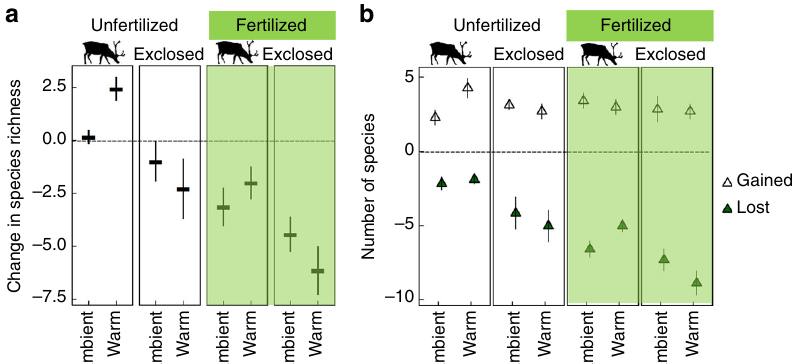
Fig. 1 Change in plant species richness from 2009 to 2014. a Changes in total plant species richness and b numbers of plant species (mean ± s.e.m., n = 7 for each point) lost and gained under warming, herbivore exclosure and fertilization treatments. Total plant species richness at the start of the experiment was 21.6 ± 0.58 (mean ± s.e.m.) species in 25 × 50 cm 2 quadrats ( n = 56)